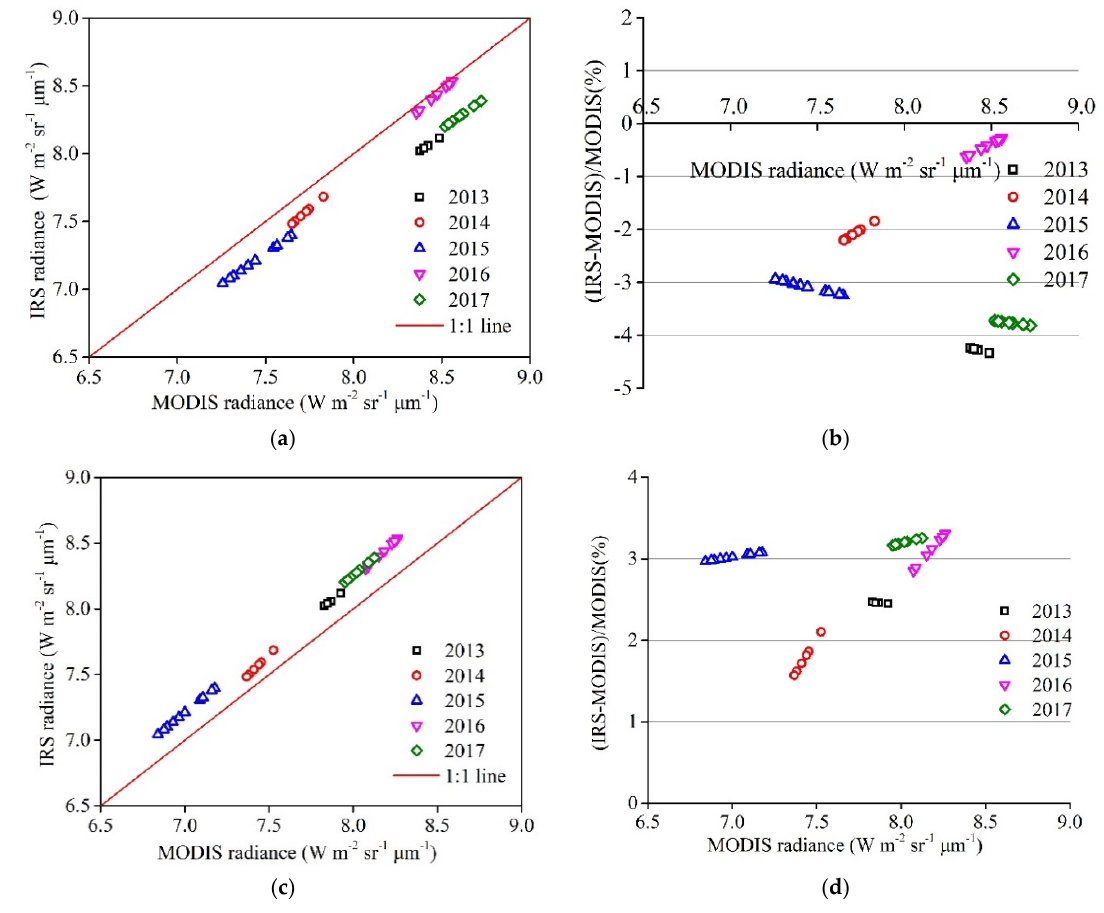
Figure 9. Comparison of radiance obtained from images of both IRS and MODIS sensors. IRS radiances were calculated using the calibration coefficients of this study. The MODIS radiances were obtained from MODIS L1B products. ( a ) IRS B08 vs. MODIS B31 radiance; ( b ) percent difference relative to MODIS B31; ( c ) IRS B08 vs. MODIS B32 radiance; ( d ) percent difference relative to MODIS B32